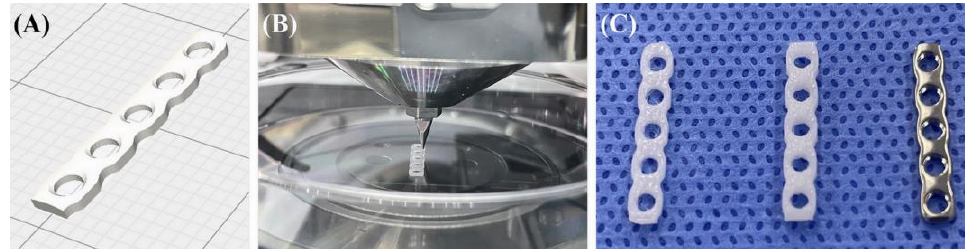
Figure 1. Design and production of polycaprolactone (PCL) plate. ( A ) Design image of the PCL plate. ( B ) PCL plate production process via a dispensing-type 3-D bioprinter. ( C ) From the left, 1-mm PCL plate, 2-mm PCL plate, and 1.5-mm titanium plate, respectively.